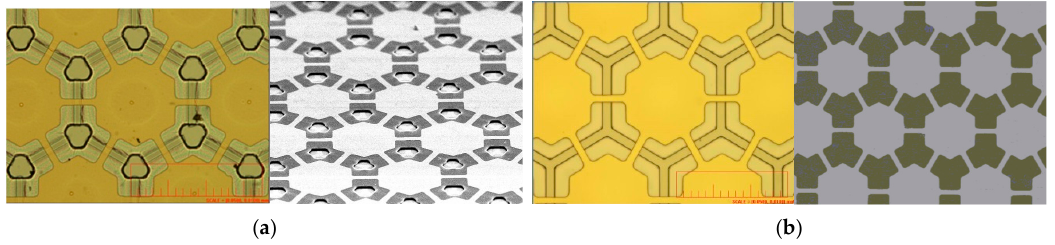
Figure 6. ( a ) CMUT made by the sacrificial-layer technique (left: optical microscope (OM) image; right: scanning electron microscope (SEM) image); ( b ) CMUT made by the roll-lamination technique (left: OM image; right: SEM image).